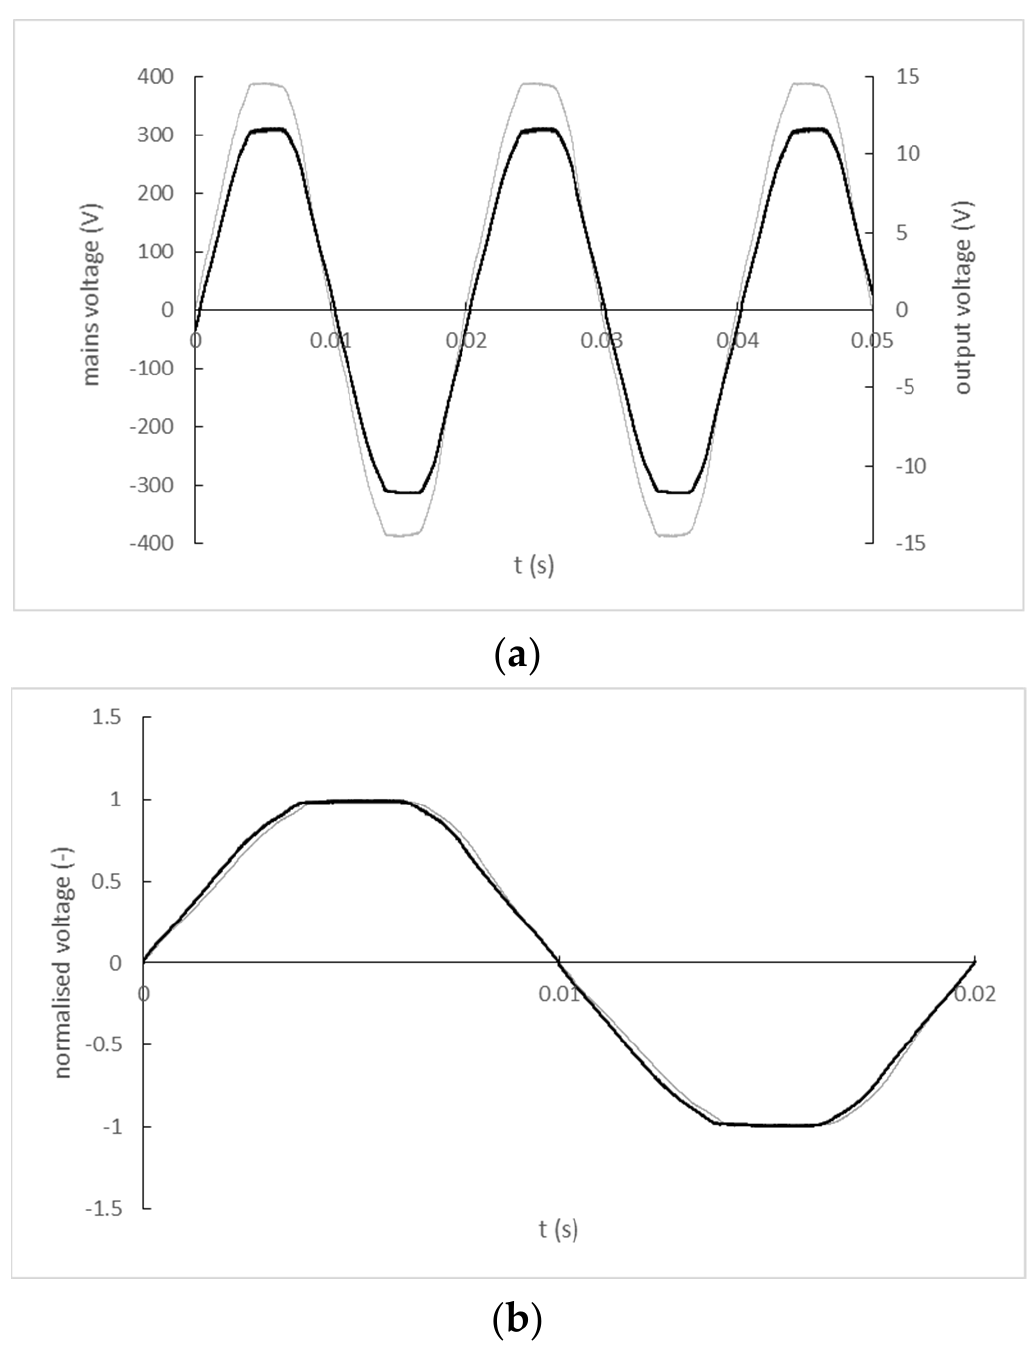
Figure 10. ( a ) The input and output signal record of the BV EI 305 2055 transformer (black line– mains, grey line–output); ( b ) Normalized and zero-crossing time shift-corrected input and output waveforms BV EI 305 2055 transformer (black line—mains; grey